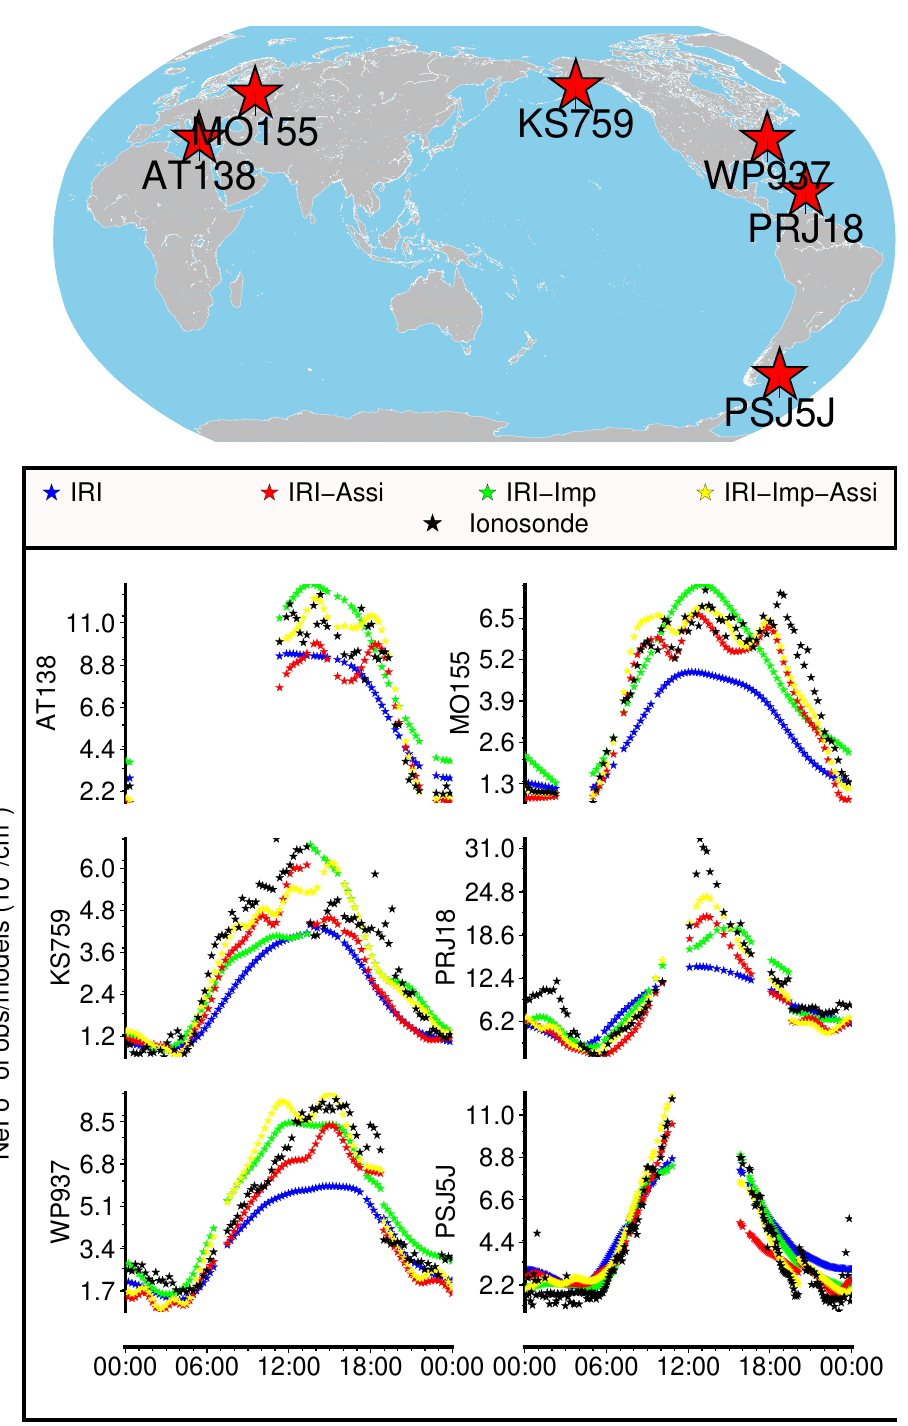
Figure 11. Sample ionosonde stations’ distribution ( top ); and their NeFo2 comparing with ionospheric models on DOY 89, 2012 ( bottom